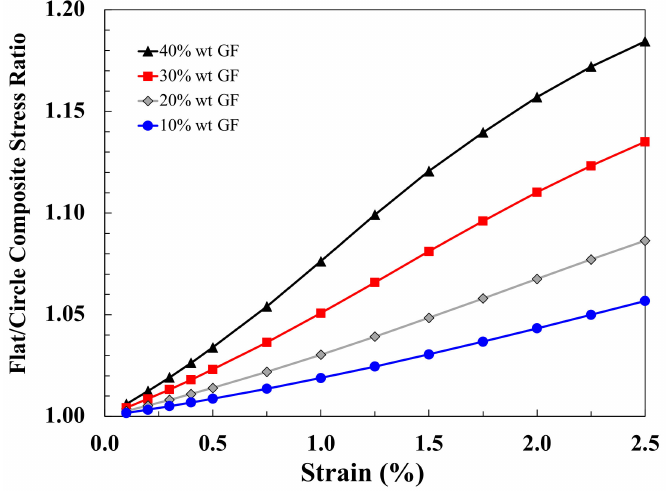
Figure 9. Prediction of flat/circle ratio of stress in injection moulded GF-PP composites for K = 4 flat fibres.